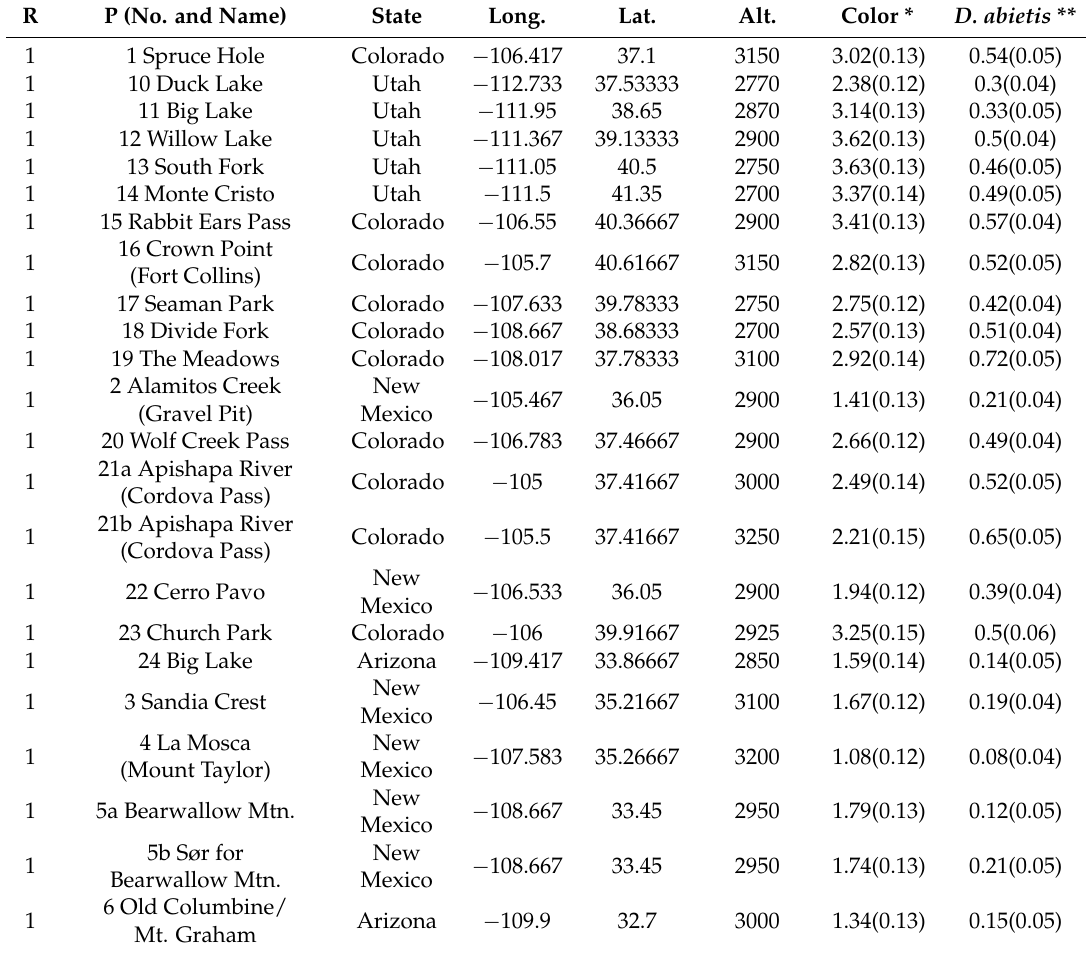
Table A1. Provenance (P) means and standard errors (in brackets) for foliage color and infection level by Delphinella abietis registered in the subalpine fir ( Abies lasiocarpa ) provenance trial at Jønsberg in July 2013. Origin of seed sources in each state is given by longitude (Long.), latitude (Lat.) and altitude (Alt.–given in meters above mean sea level). Regions (R) reflect the three regions given in Figures 1 and 8 (1 = South, 2 = Middle, 3 =